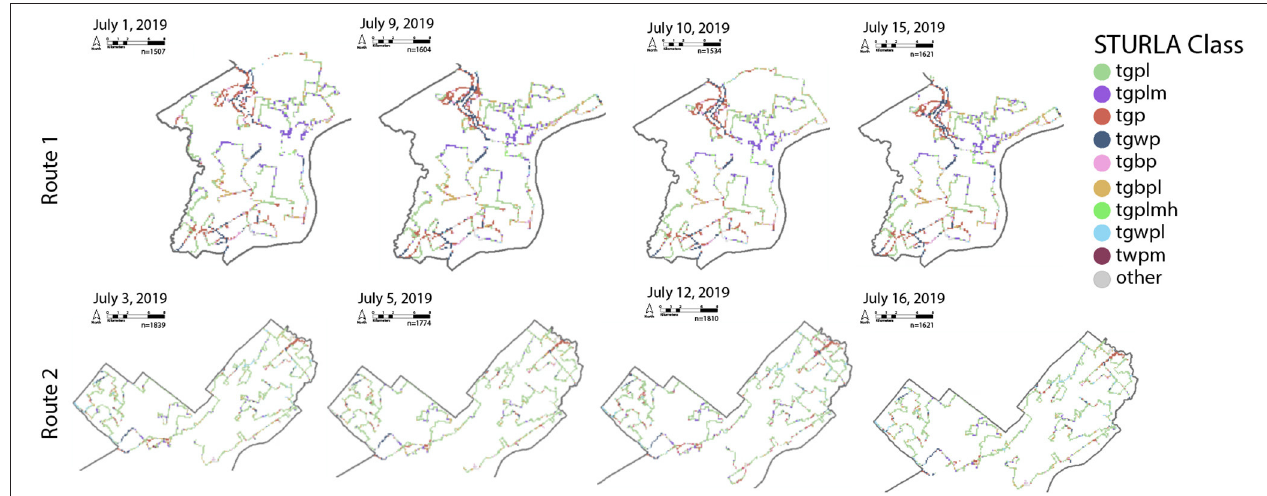
FIGURE 2 | Sampling routes for each day of collection, colors correspond with STURLA class. The reader is encouraged to zoom in on each map to examine the spatial distribution of sampling and the corresponding STURLA class. T, trees; G, grass; B, bare; W, water; P, pavement; L, low-rise; M, midrise; H, highrise. The combination of these individual letters creates a STURLA code; for example, class tgpl is composed of various proportions of trees (T), grass (G), pavement (P), and low-rise buildings